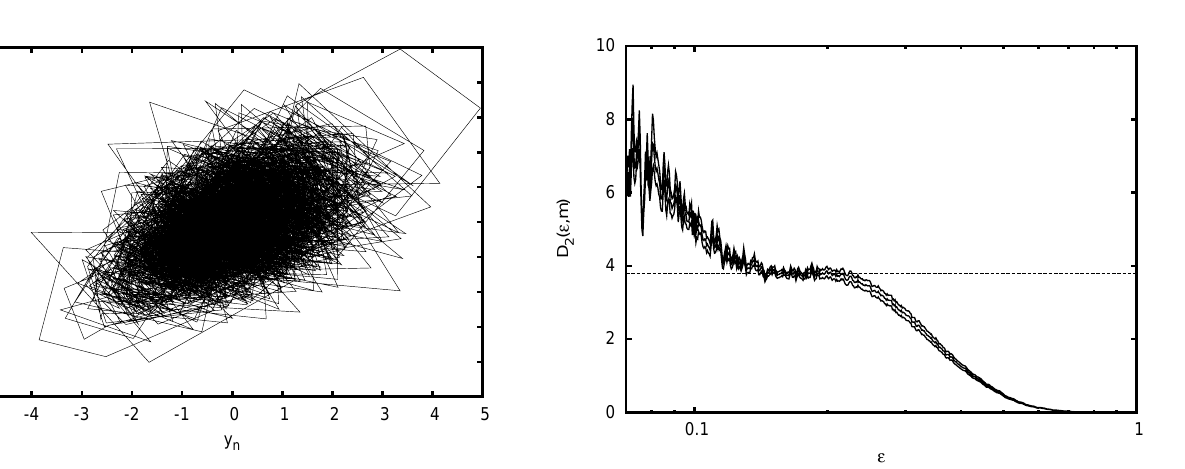
Fig. 8. The delay representation of the detrended time series.